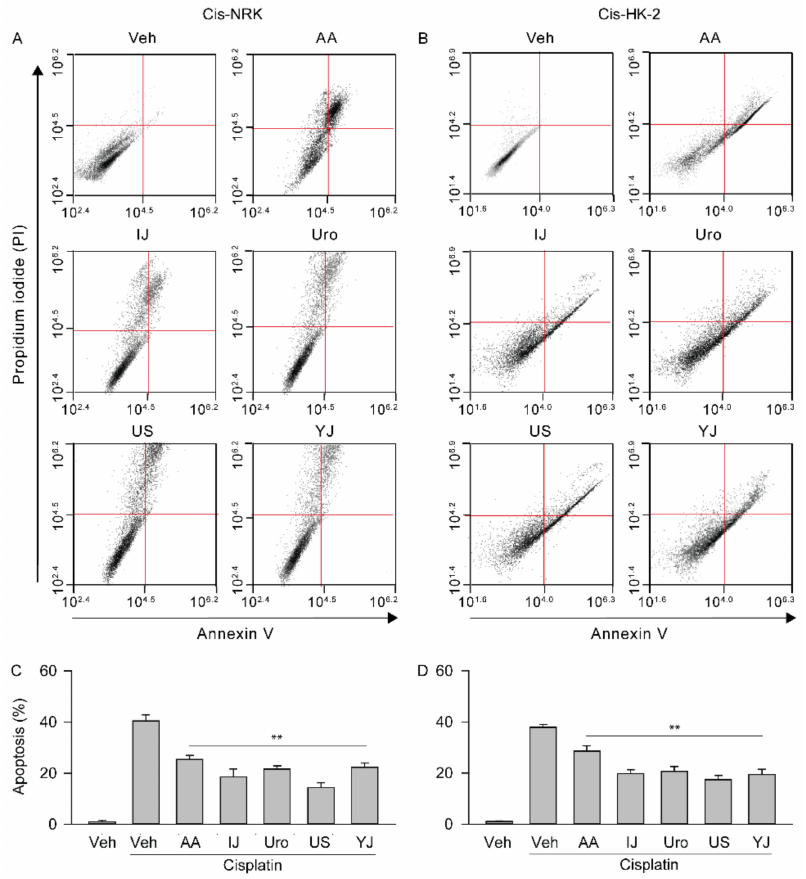
Figure 4. E ff ects on apoptotic changes. The cisplatin-induced NRK (Cis-NRK, ( A )) and HK-2 (Cis-HK-2, ( B )) cells were treated with AA, IJ, Uro, US, or YJ, and apoptosis was measured by the annexin V- and PI-double positive cells by flow cytometry. The results are expressed as percentages of the cisplatin non-treated normal control ( C , D ). Values are means ± SD from three independent experiments. **: p < 0.01 versus the cisplatin-treated Veh